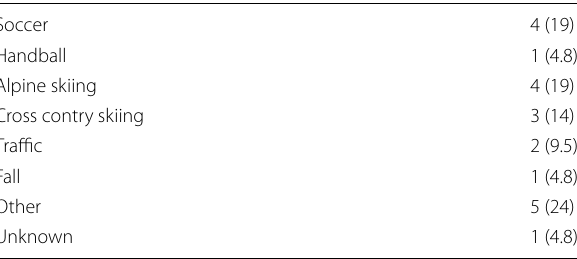
Table 1 The number of patients (%) in different type of activities leading to the